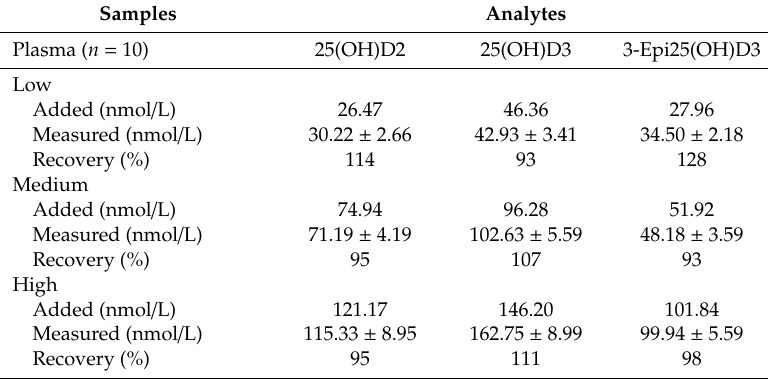
Table A3. Recovery ( n = 10) of vitamin D metabolites in plasma, breastmilk, and infant formula at